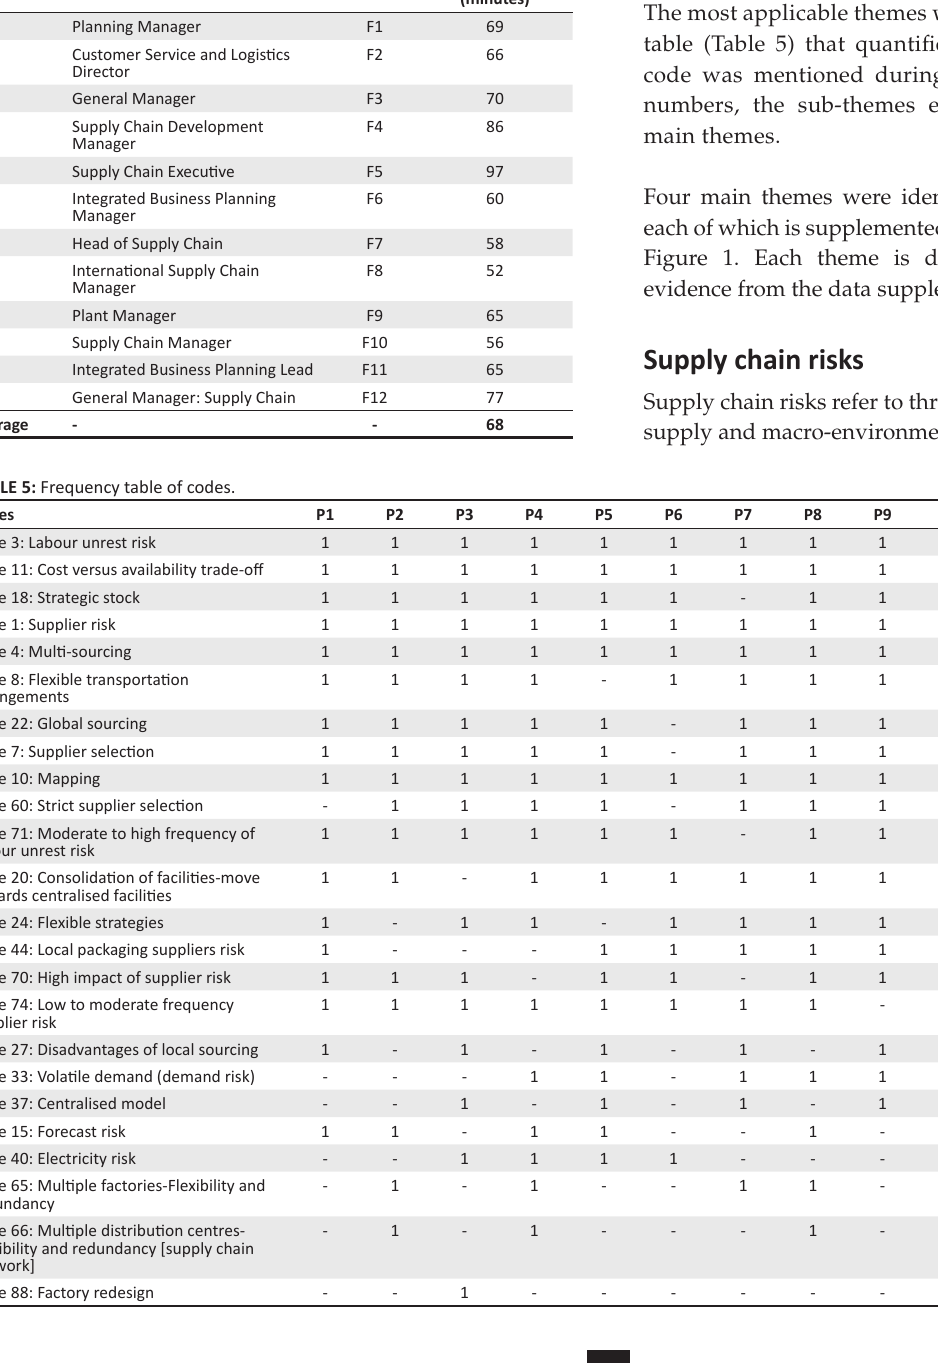
Code 65: Multiple factories-Flexibility and redundancy Code 66: Multiple distribution centres- Flexibility and redundancy [supply chain